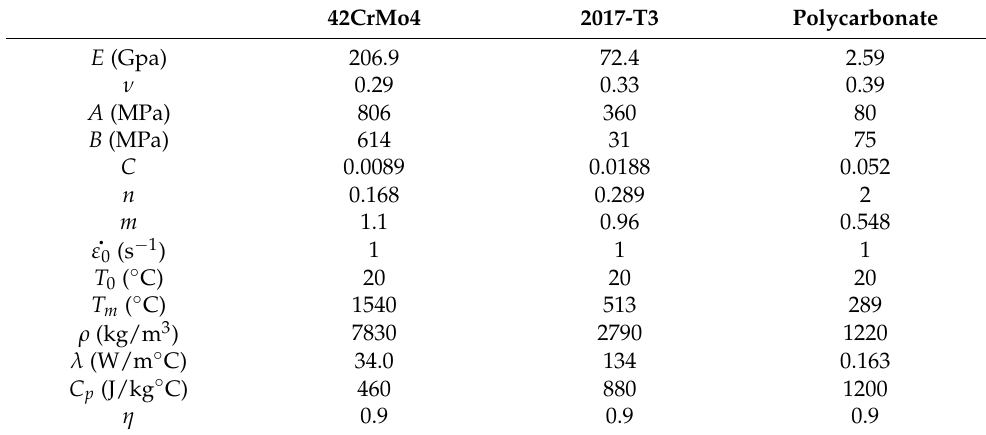
Table 2. Material parameters of the 42CrMo4 steel [19], the 2017-T3 aluminum [8], and the polycar- bonate [20].